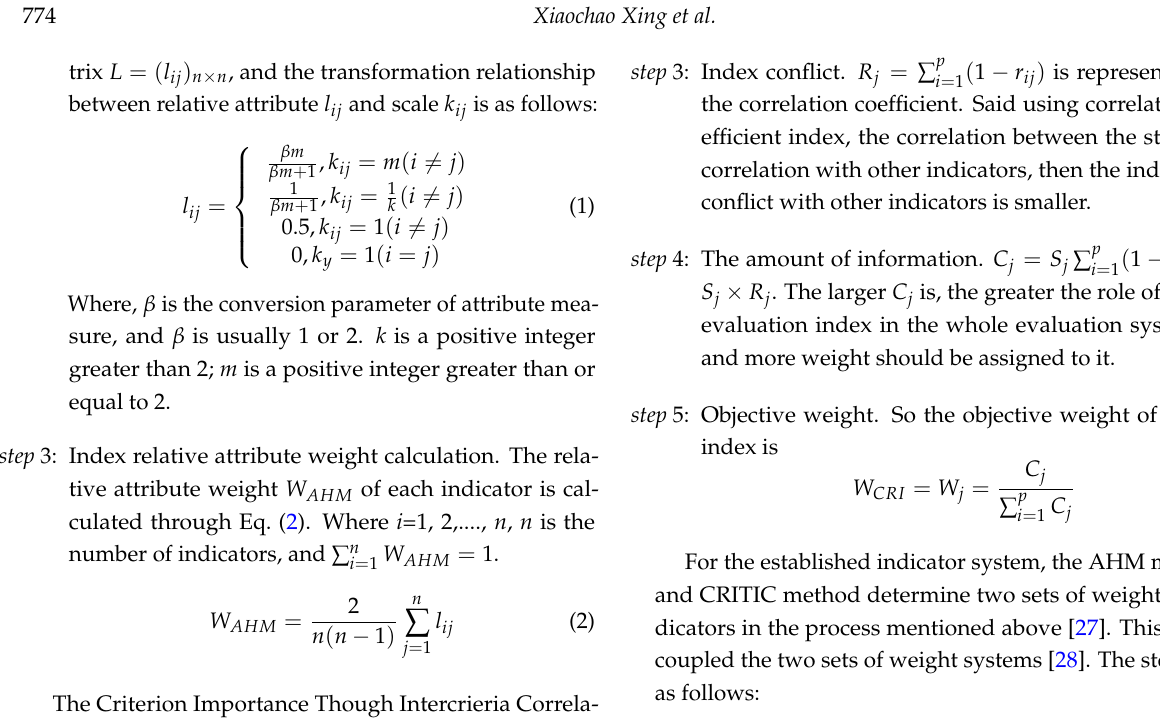
the correlation coefficient. Said using correlation co- efficient index, the correlation between the stronger correlation with other indicators, then the index will conflict with other indicators is